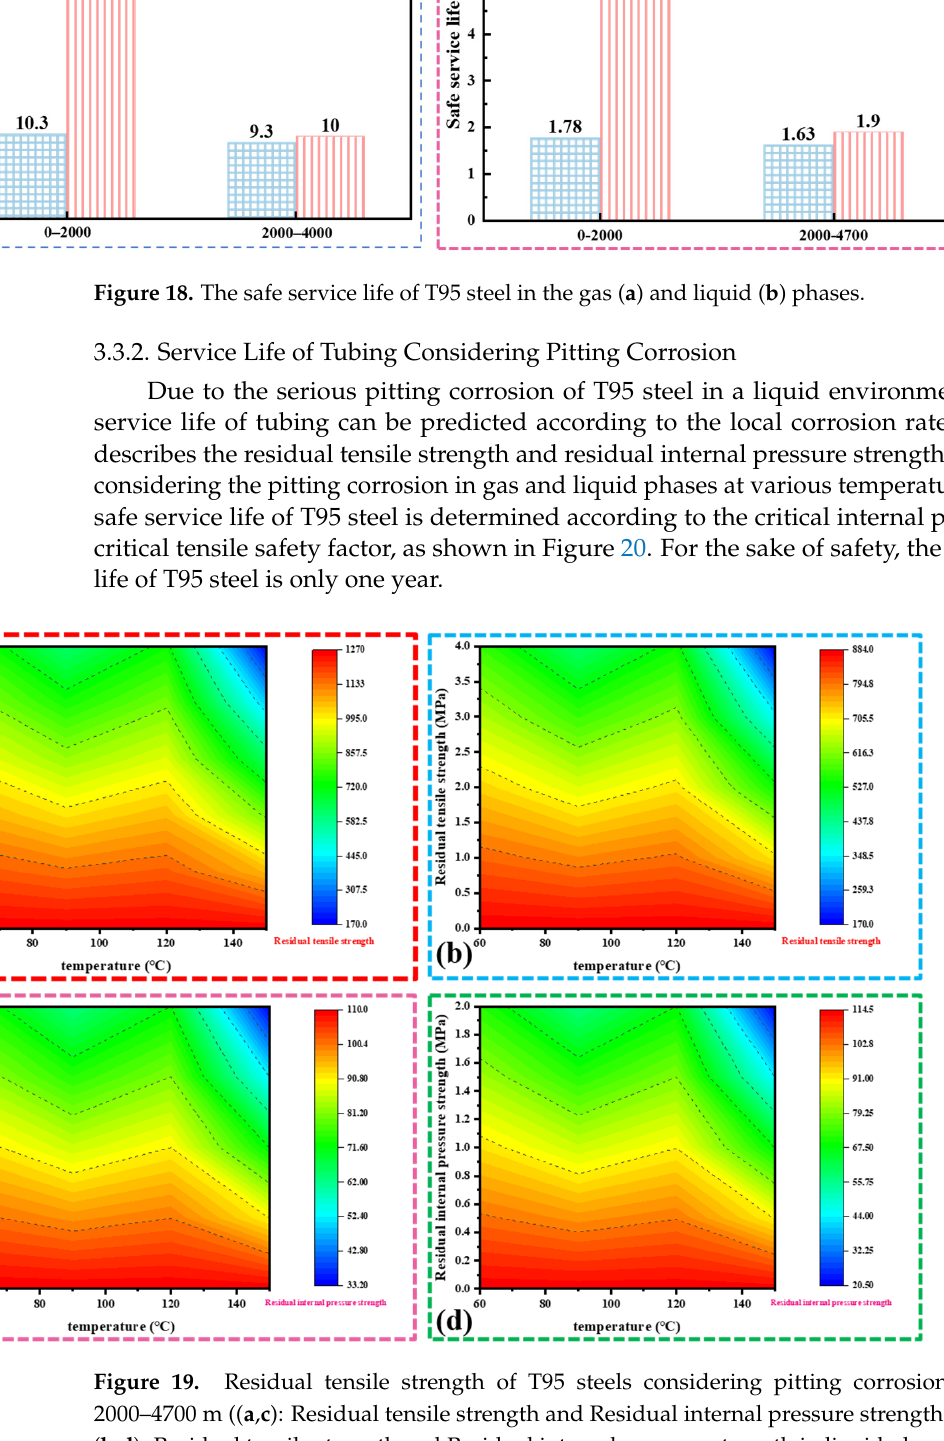
Figure 20. The safe service life of T95 steel in the liquid phase considering pitting corrosion. 4. Discussion 4.1. Pitting Corrosion of T95 Steel in Liquid Phase In the liquid phase, CO 2 and H 2 S dissolve in the solution to produce the corrosive ions, including HS − , S 2 − , CO 3 2 − , and HCO 3 − ions [36,37]. The cathodic and anodic reactions in the solution are as follows [38]. 2